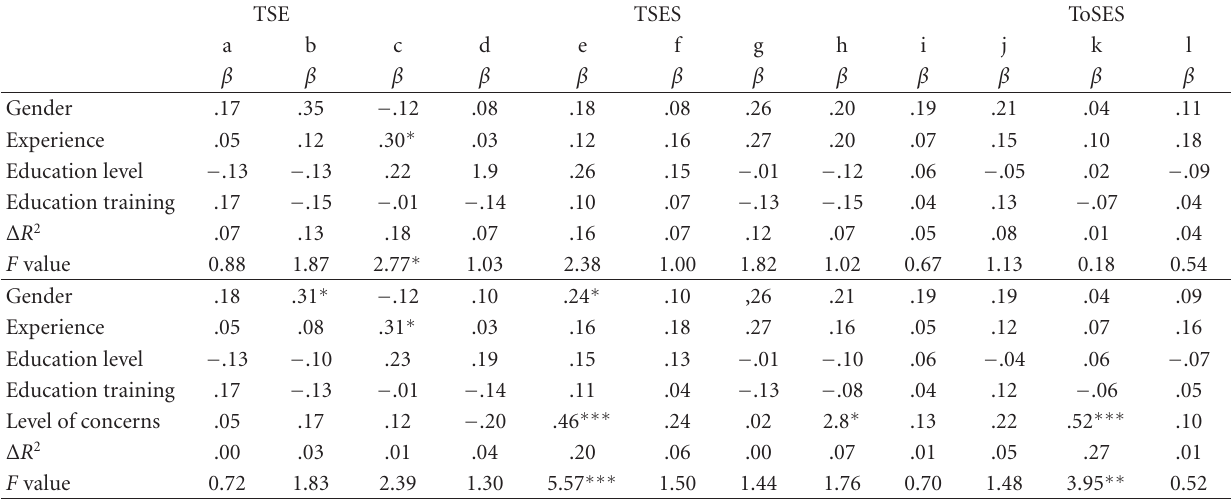
Table 2: Hierarchal regression analysis on predicting variables of teacher e ffi